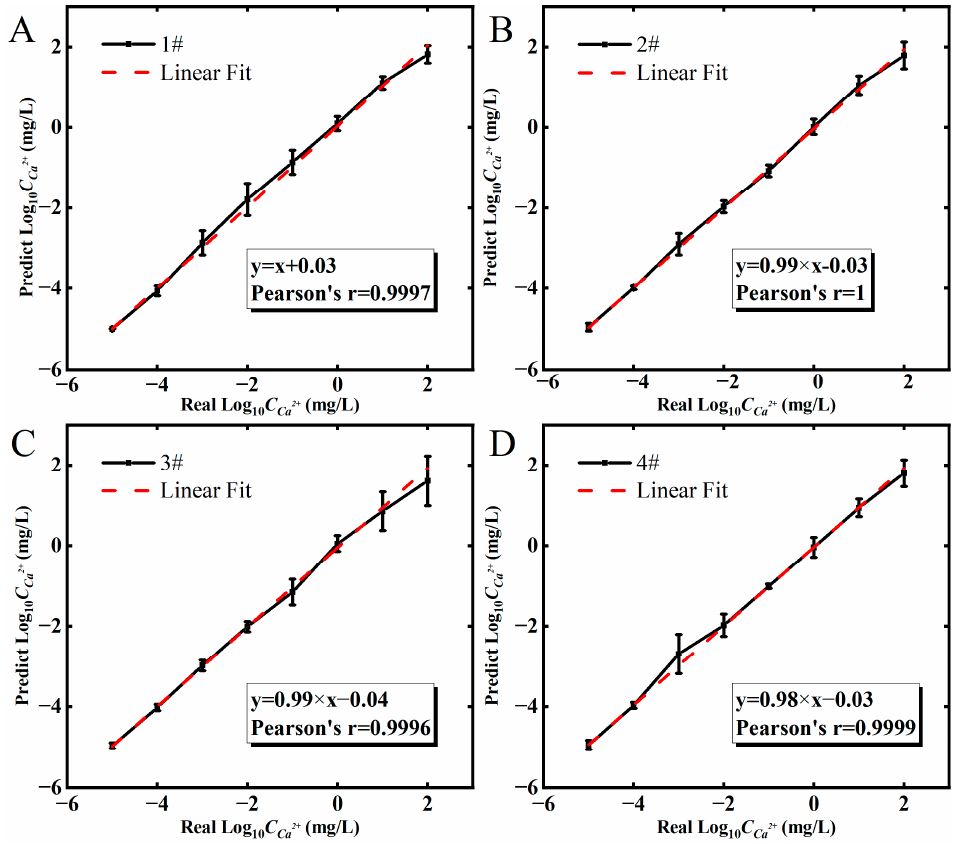
Figure 6. The results of C Ca 2 + calibration-free determination for four individual Eg-GFET sensors named as 1# ( A ); 2# ( B ); 3# ( C ); 4# ( D ), respectively. The error bar represents the standard deviations for n measurements (n = 500).